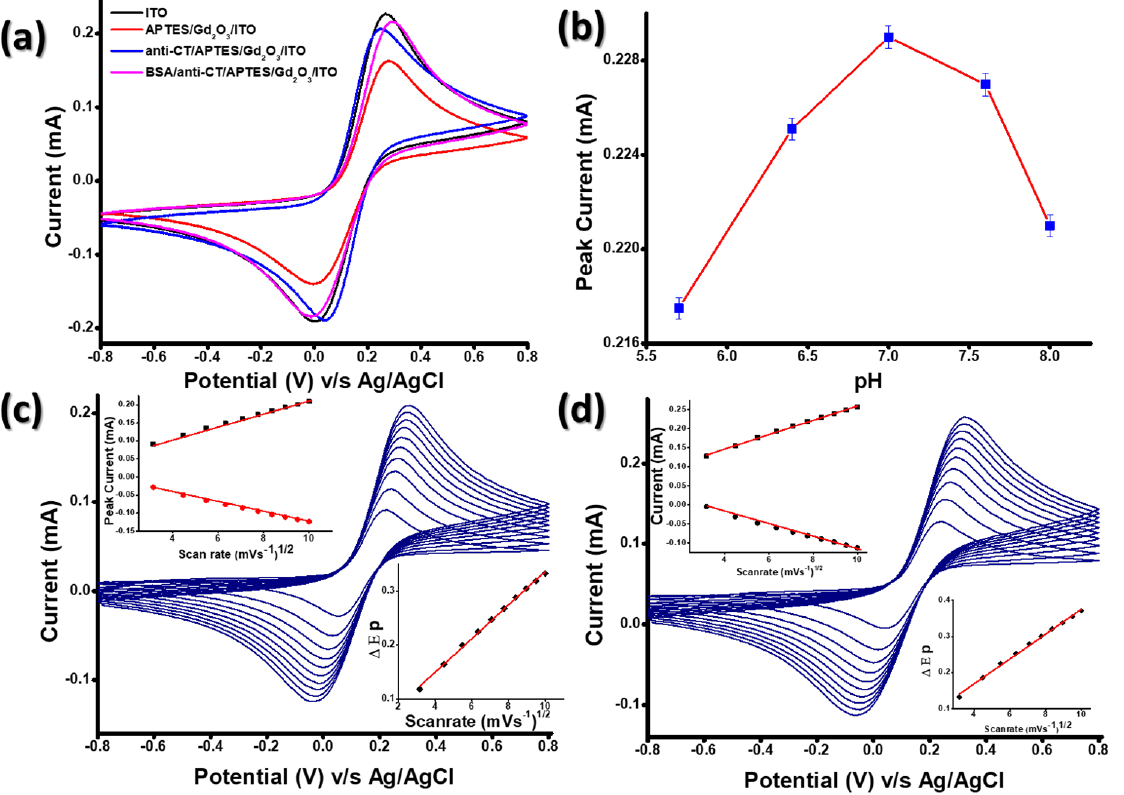
Figure 6. ( a ) CV study of (i) ITO; (ii) APTES-Gd 2 O 3 /ITO; (iii) anti-CT/APTES-Gd 2 O 3 /ITO; (iv) BSA/anti-CT/APTES-Gd 2 O 3 /ITO electrodes in PBS containing[Fe(CN) 6 ] 3 − /4 − at a scan rate of 0.05V s − 1 , ( b ) effect of pH on the BSA/anti-CT/APTES-Gd 2 O 3 /ITO immunoelectrode, ( c ) scan rate response of APTES-Gd 2 O 3 /ITO electrode and ( d ) scan rate response of BSA/anti-CT/APTES-Gd 2 O 3 /ITO electrode.